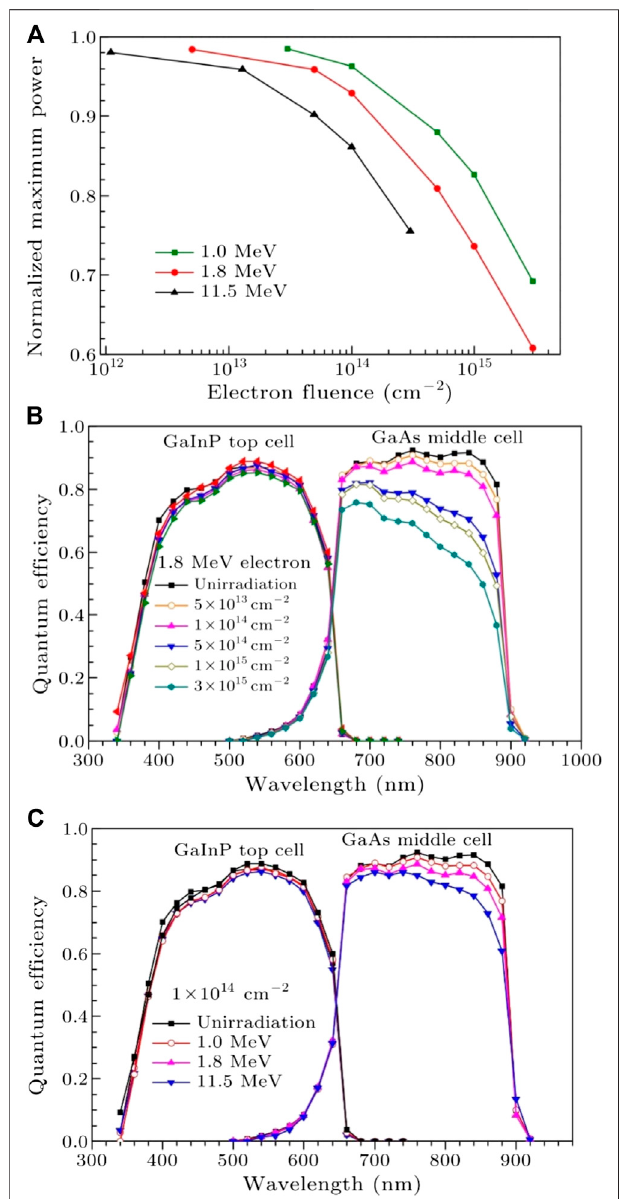
FIGURE 6 | (A) The normalized P max degradation of GaInP/GaAs/Ge solar cell under different energy electron irradiation with different particle fl uence; (B) The degradation of EQE with 1.8 MeV electron irradiation and (C) with different energy electrons with a particle of 1 × 10 14 cm − 2